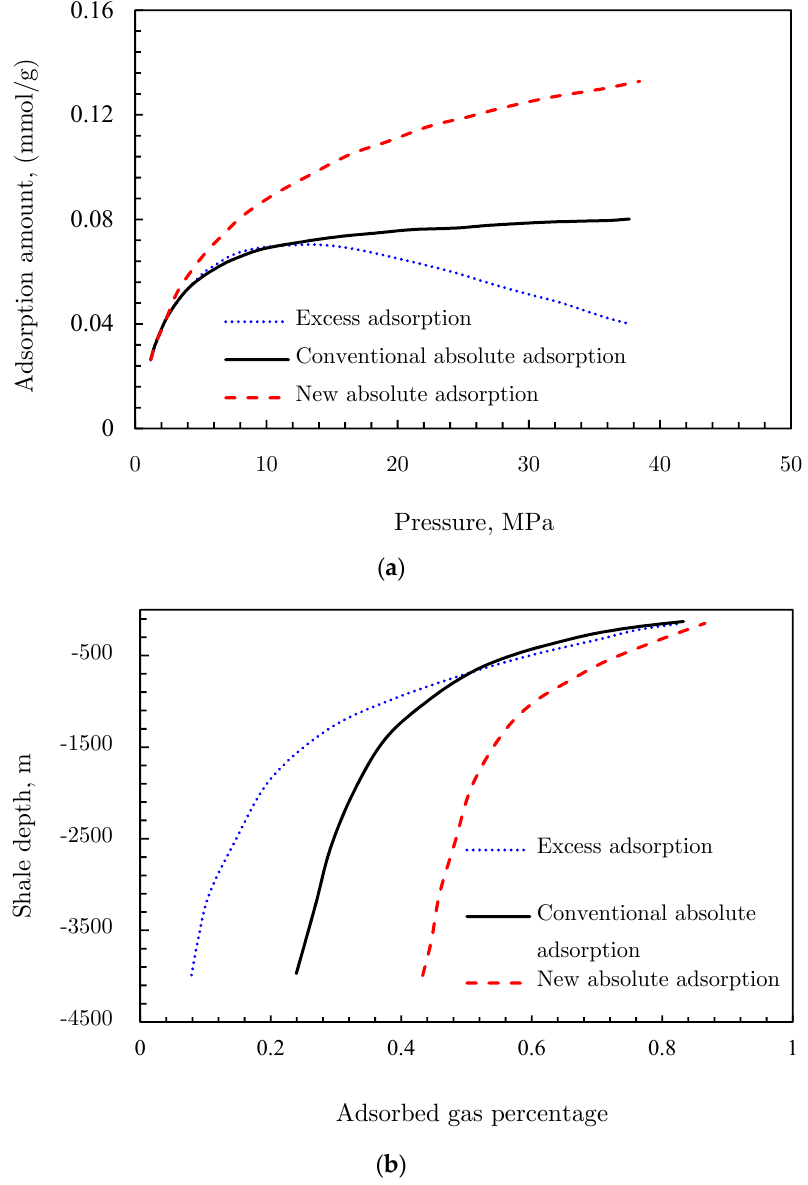
Figure 20. Adsorption amount versus pressure ( a ) and adsorbed gas percentage versus shale formation depth ( b ) in different models [61].